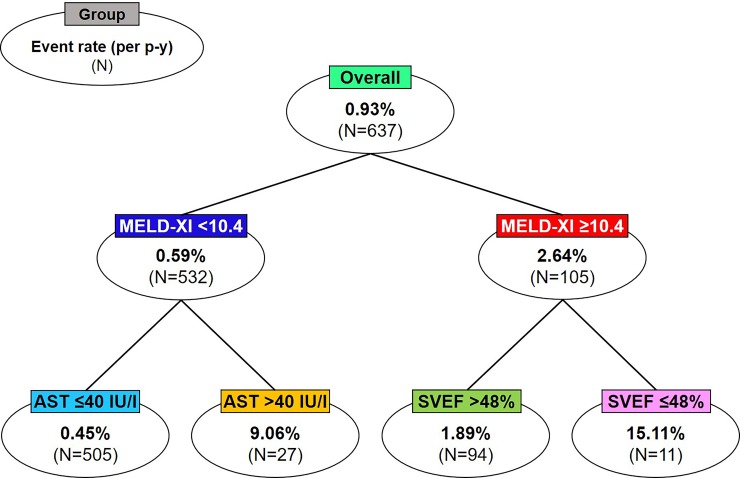
Survival CART analysis and prognostic value of the MELD-XI score in ACHD patients.The survival CART analysis revealed that MELD-XI score was the primary discriminator of MACE (P<0.001), indicating that the score is the most useful prognostic factor for MACE in ACHD patients. ACHD, adult congenital heart disease; AST, aspartate aminotransferase; CART, classification and regression tree; MACE, major adverse cardiac events; MELD-XI, model for end-stage liver disease excluding international normalized ratio; p-y, person-year; SVEF, systemic ventricular ejection fraction.